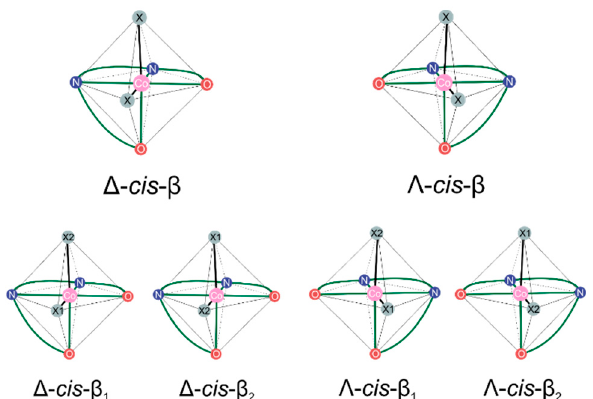
Figure A1. Idealized visualization of enantiomeric arrangement of N 2 O 2 Schiff base donor atoms resulting in the nonsuperimposable structures of cis ‐β complexes. Additional ligands are marked as X (or X1/X2 if priority precedence is important). Arabic numbers are used to express Cahn–Ingold–Prelog (CIP) atom priority precedence i.e., X1 has higher priority than X2.